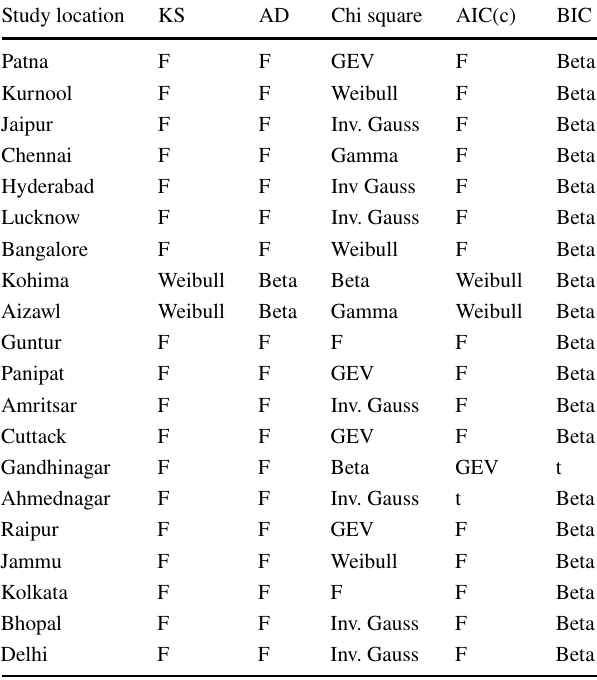
Table 4 Station-wise best- fit distribution obtained by summing the ranks of each of the distributions from all the model comparison